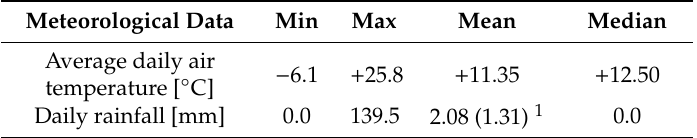
Table 3. Variability of investigated meteorological data in the studied period.